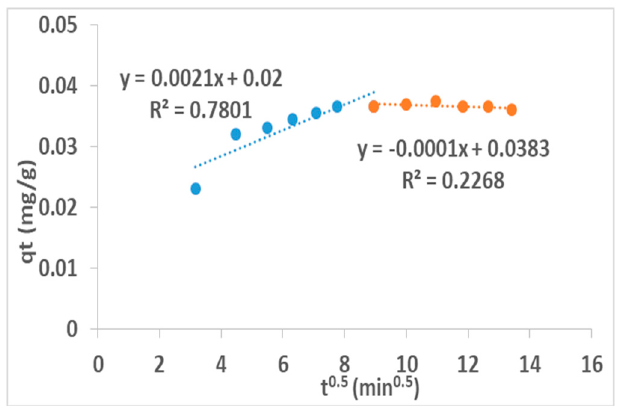
Table 6. Int. J. Environ. Res. Public Health 2019 , 16 , x FOR PEER REVIEW